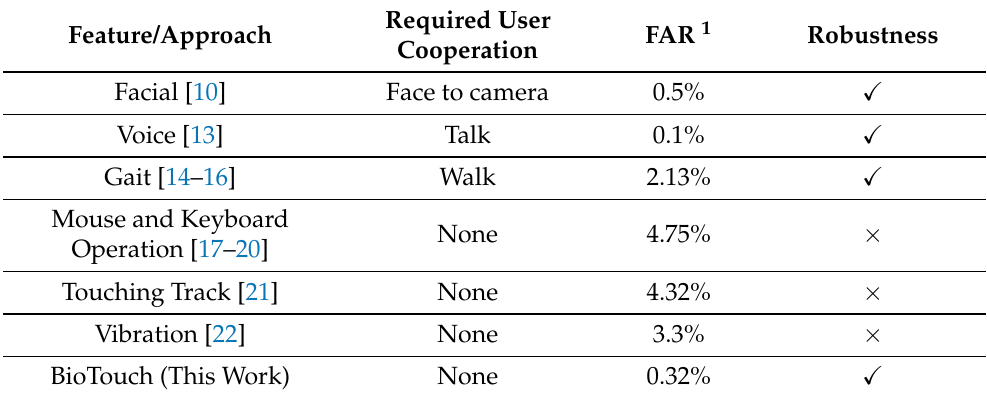
Table 1. Summary of related works on user re-authentication.